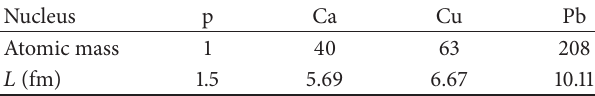
Table 1: Values of 𝐿 used in p, Ca, Cu, and Pb